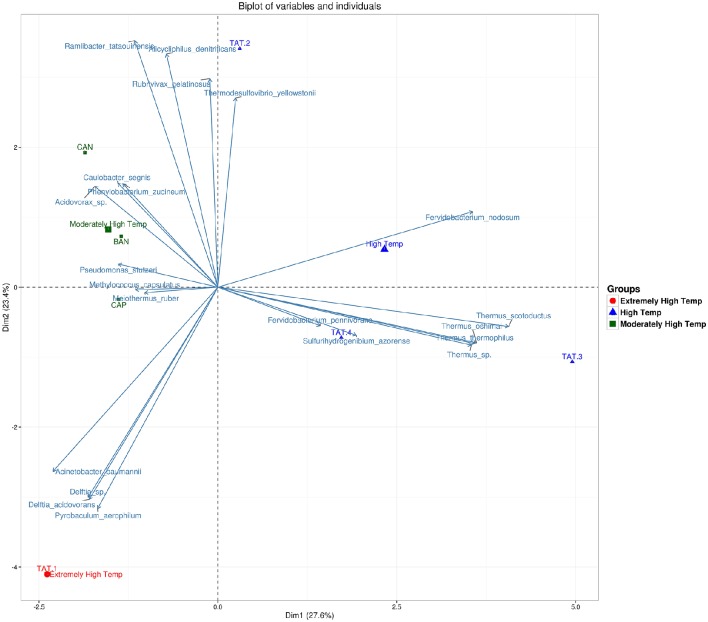
Biplot showing an association of species with sample groups based on temperature. Principle component analysis of samples grouped using temperatures and their association with species are shown as vectors on ordinations.